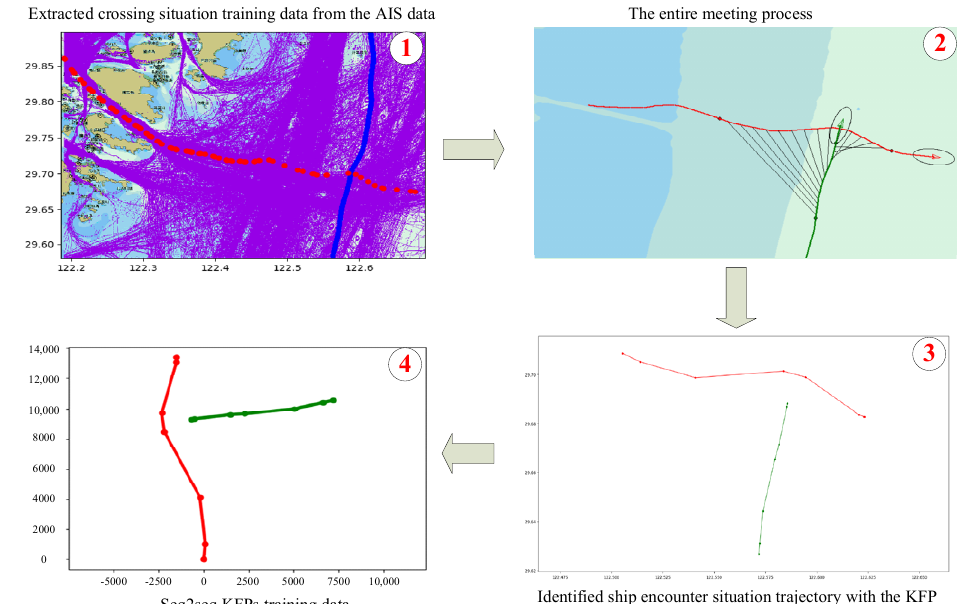
Figure 18. Preparation of the encoder–decoder training data.